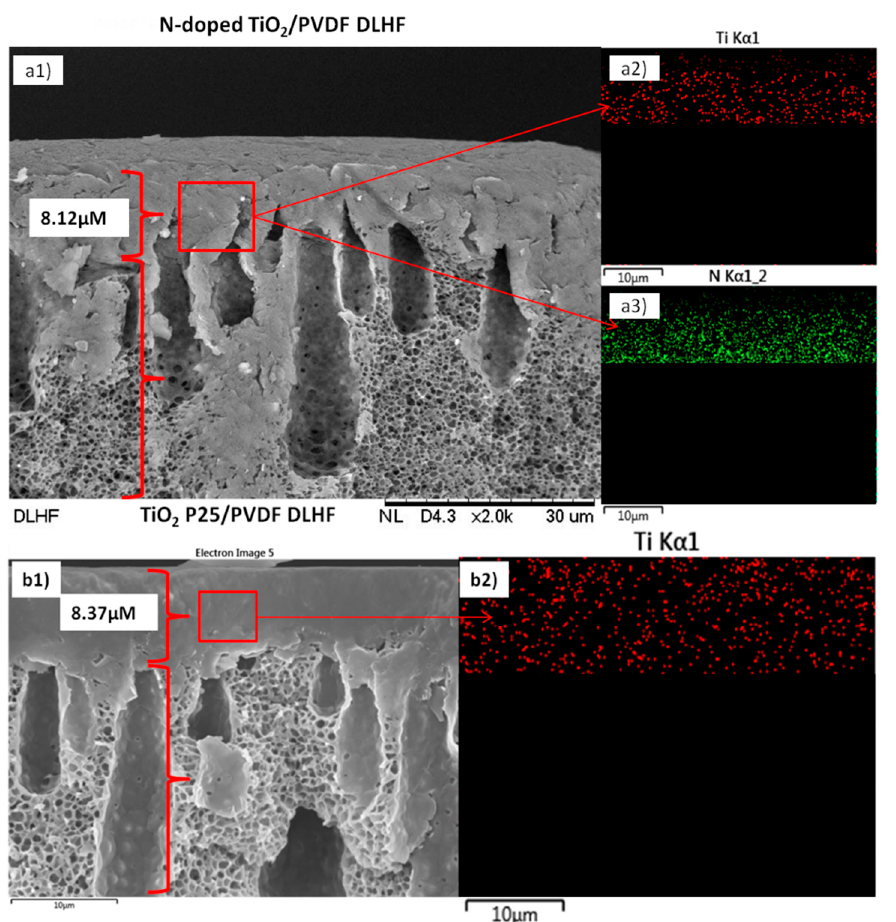
Figure 2. SEM images and energy dispersion X-ray analysis (EDX) mapping of ( a1 , a2 , a3 ) N-doped TiO 2 and ( b1 , b2 ) TiO 2 -P25 DLHF membranes (( a2 , b2 ) represent the mapping image of Ti element, and a3 represent the mapping image of N element).